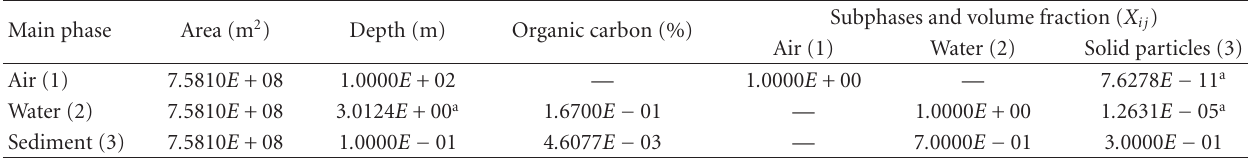
Table 1: Volume and properties of the phases and